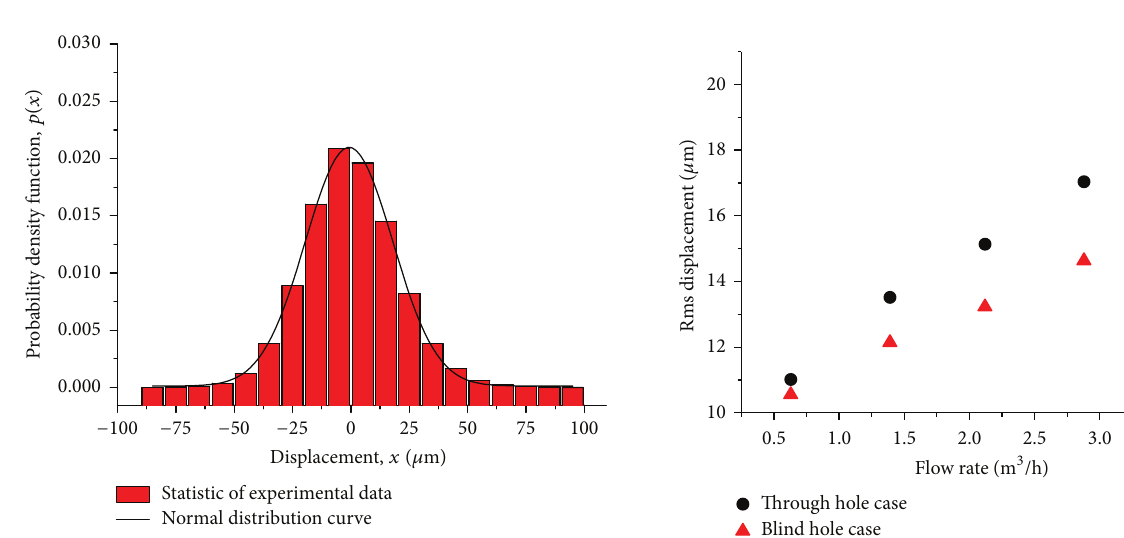
Figure 16: Probability density distributions of displacements in blind hole case at 𝑞 V = 3.62 m 3 / h.